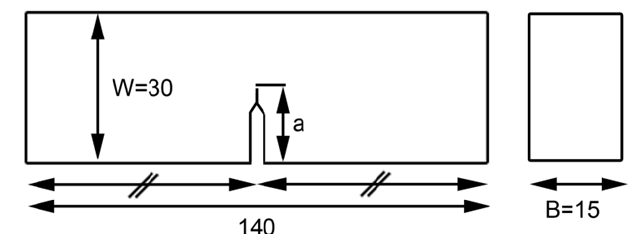
Figure 2: Single edge notch three point bending test specimen (dimensions in mm).